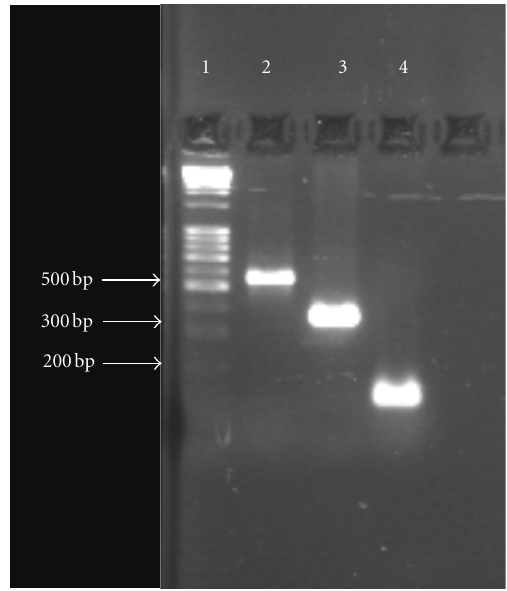
Figure 1: PCR showing 165, 365, and 541bp fragment of M. tuberculosis reference strain H37Rv (positive control). Lane 1: gene marker, Lane 2: 541 bp amplicon, Lane 3: 365bp amplicon, and Lane 4: 165 bp